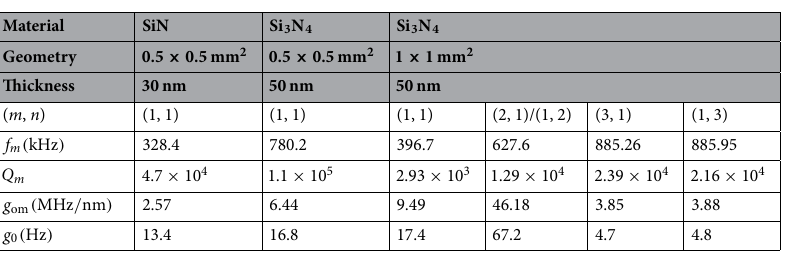
Table 2. Deduced parameters on the thermochanical spectra of the three membranes.